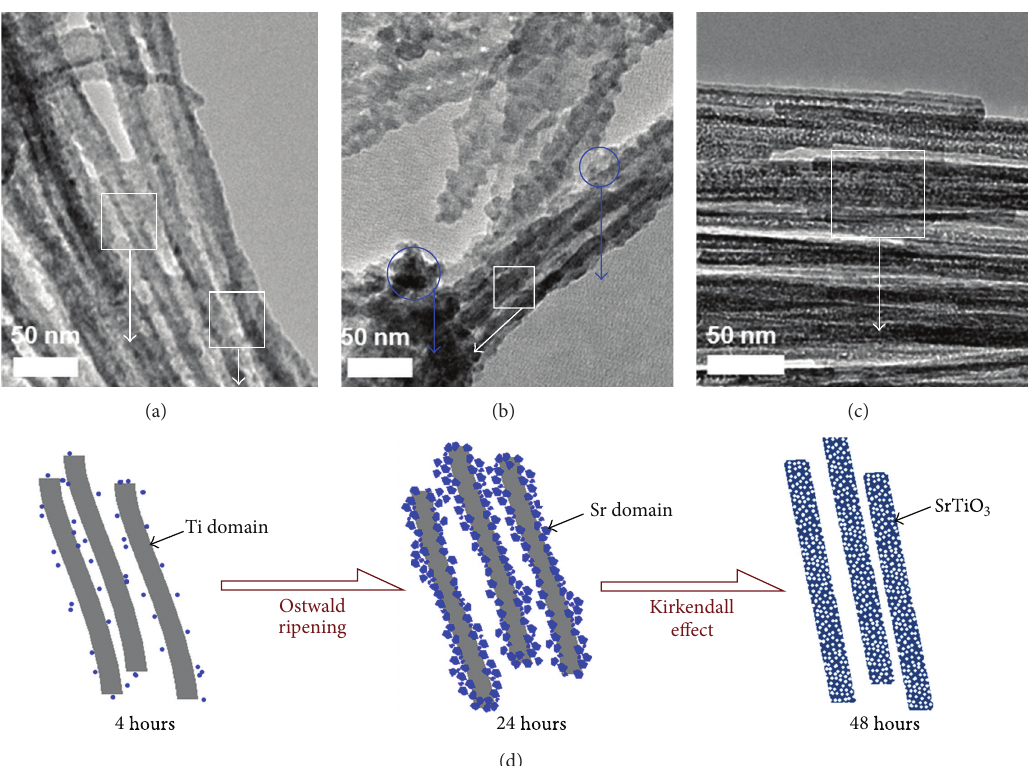
Figure2:TEM((a),(b),(c))imagesforaliquotsofthemixtureafterautoclavingfordifferenttime.Aproposedmechanismforthemesoporous NWs (d)